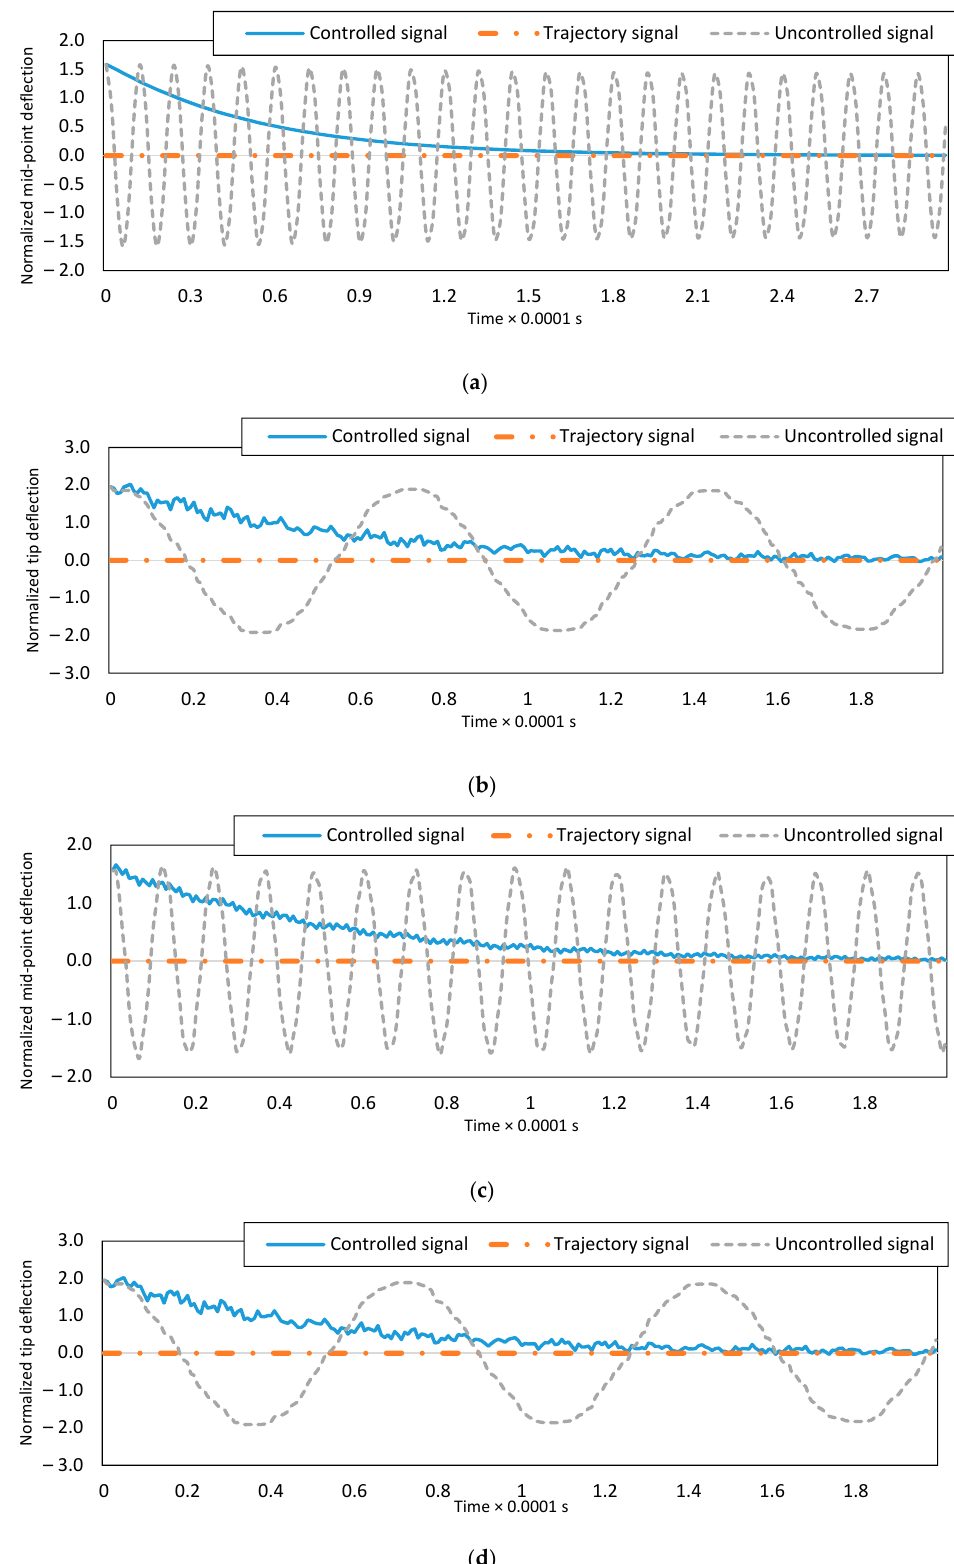
Figure 3. Controlled and uncontrolled dynamic response using one mode approximation for: ( a ) clamped-clamped and ( b ) clamped-free boundary conditions and five modes approximation for: ( c ) clamped-clamped and ( d ) clamped-free boundary conditions.